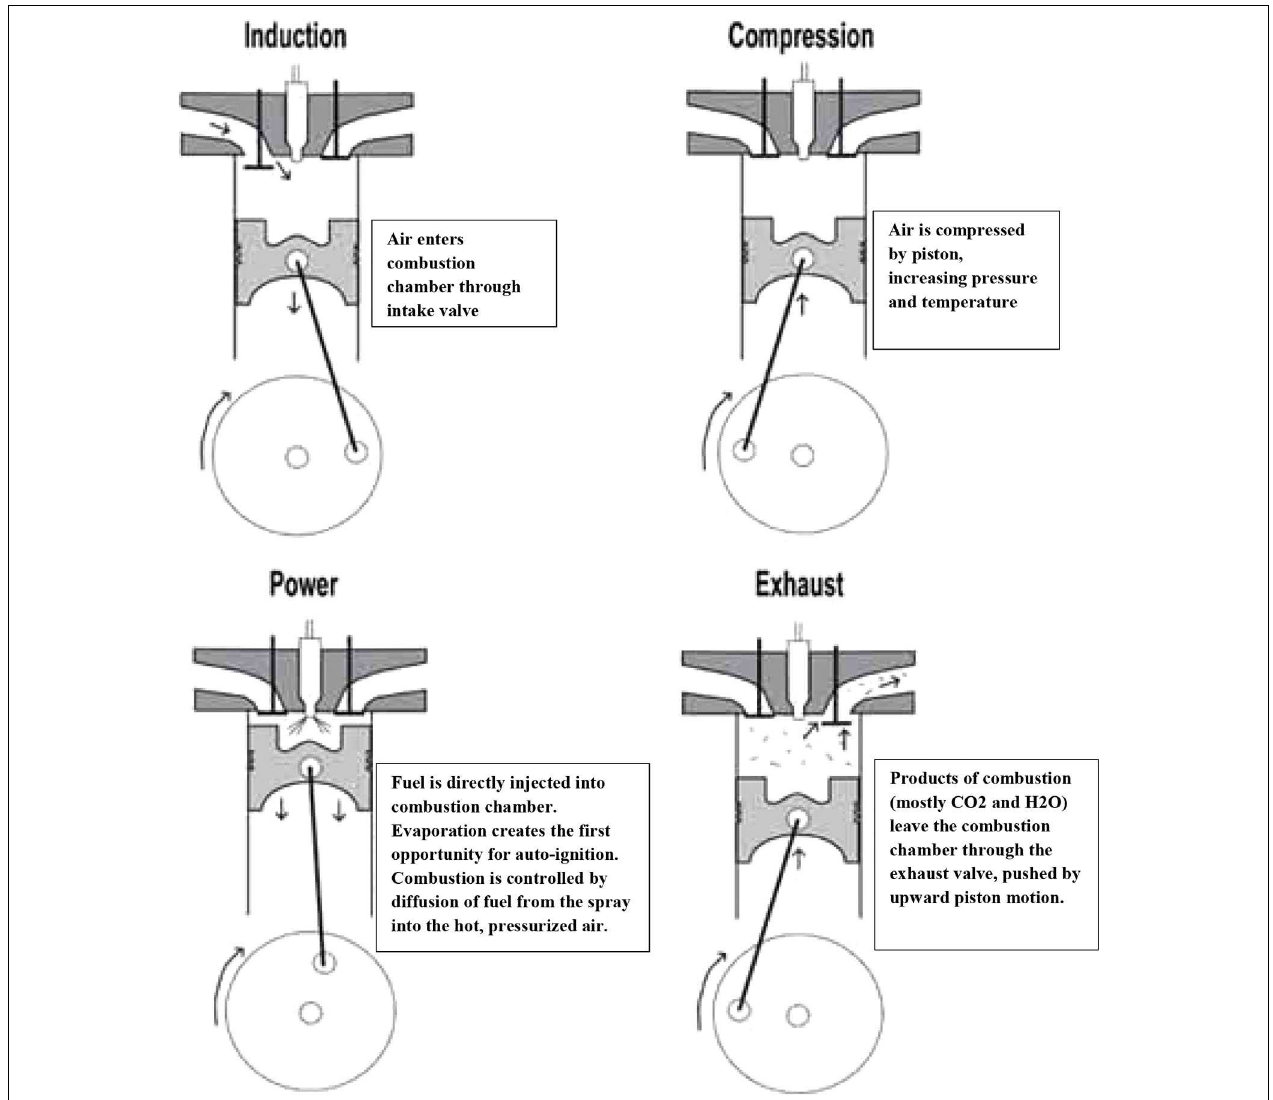
FIGURE 2 | Schematic of four-stroke compression ignition engine . Image taken from